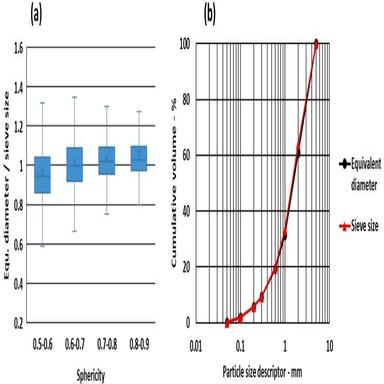
(a) box and whisker plot for the ratio values between particle equivalent diameter and sieve size as a function of particle sphericity; (b), a comparison between particle size distribution curves, using two simple descriptors for particle size: equivalent diameter and sieve size.